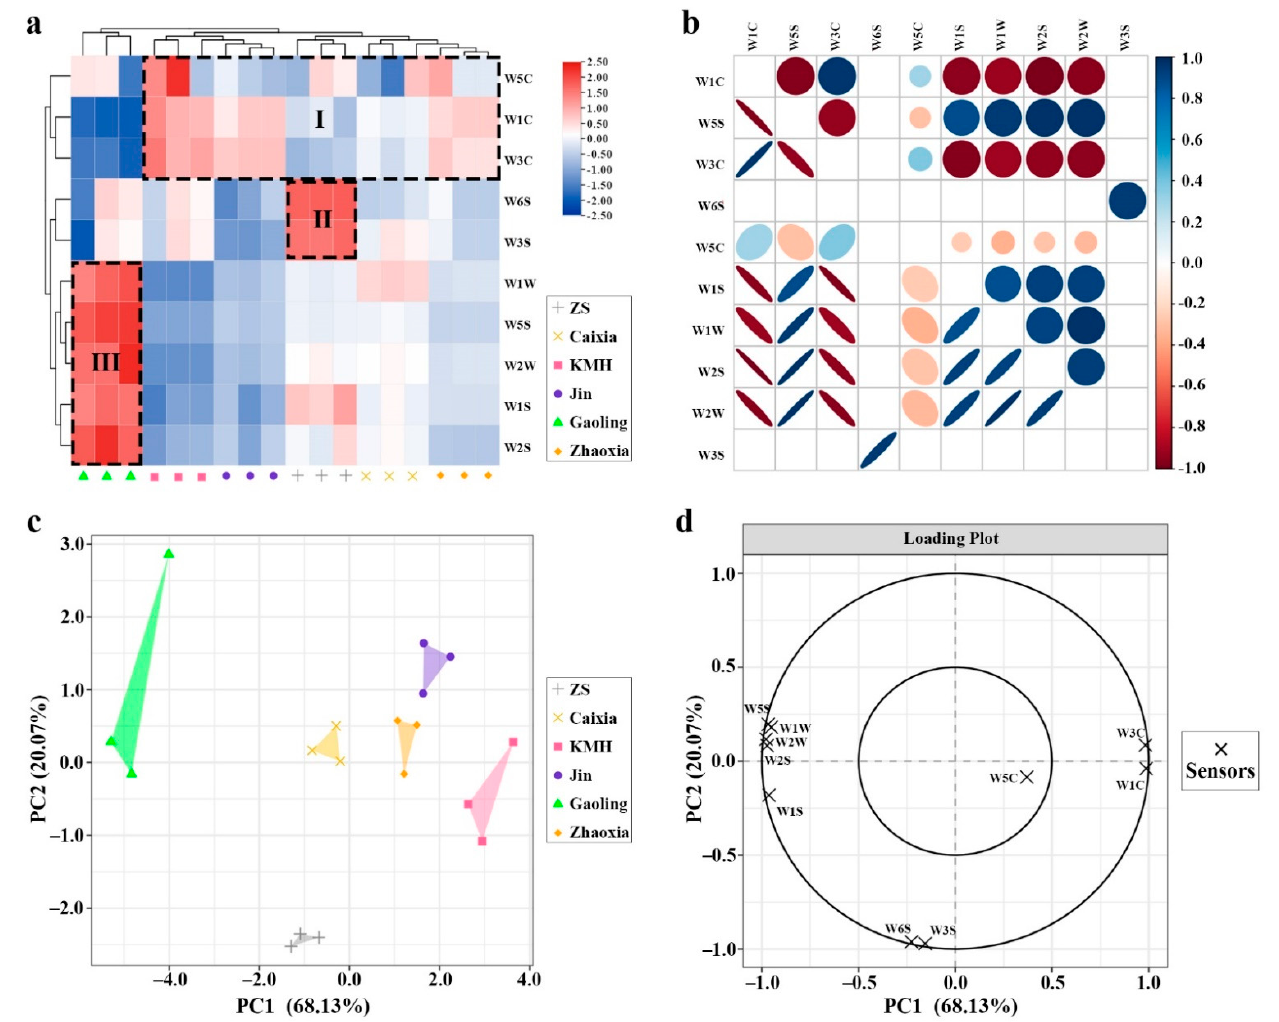
Figure 3. Multivariate analysis of floral volatile profile of six Hedychium accessions assessed by E-nose. ( a ) Heat map of response values of ten E-nose sensors in six Hedychium accessions. ( b ) Correlation matrix of ten E-nose sensors (significant ( p < 0.05) combinations are displayed). ( c ) The volatile profile distribution of six Hedychium accessions over the PCA score plot defined by the first two principal components. ( d ) The projection of the scent identified by E-nose sensor analysis.